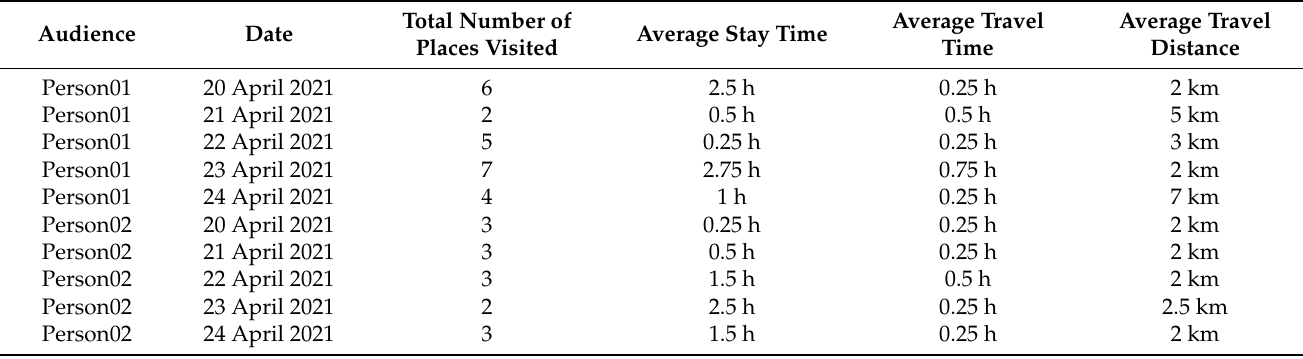
Table 9. Audiences’ daily mobile-related